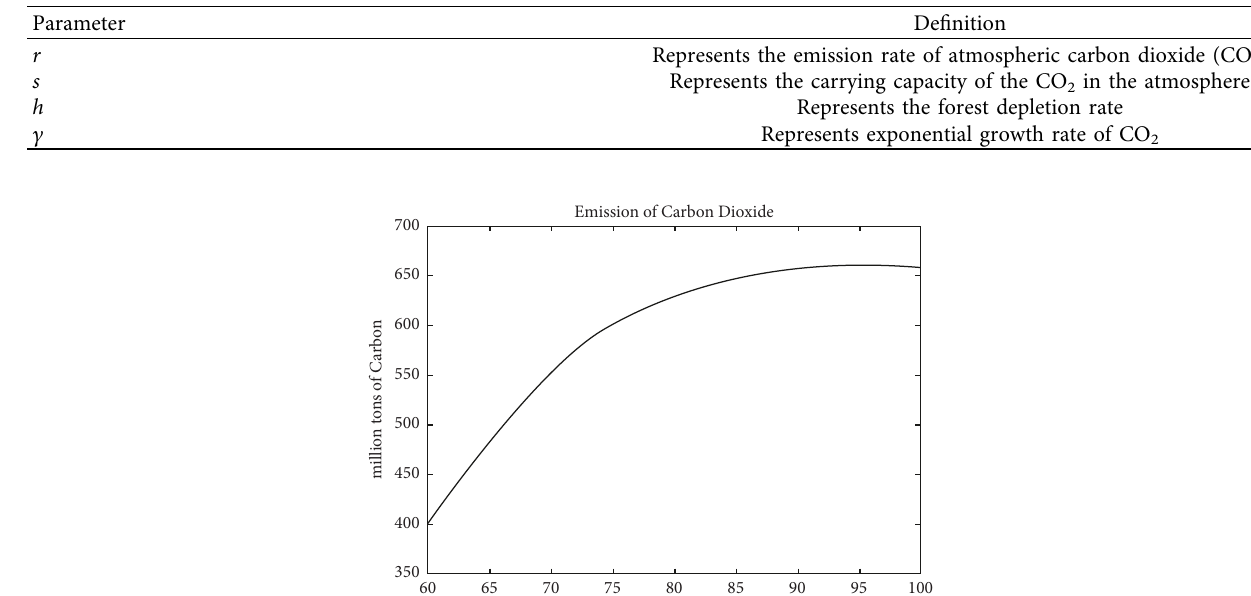
Table 2: Description of parameters.